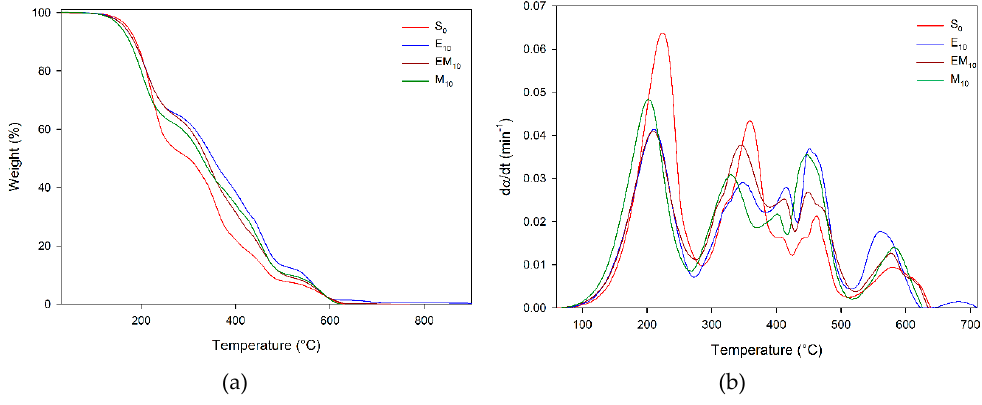
Figure 2. ( a ) TGA plots and ( b ) decomposition rate (d α /dt) of bio-based compounds. Table 3. Thermalgravimetric parameters of epoxy compounds.